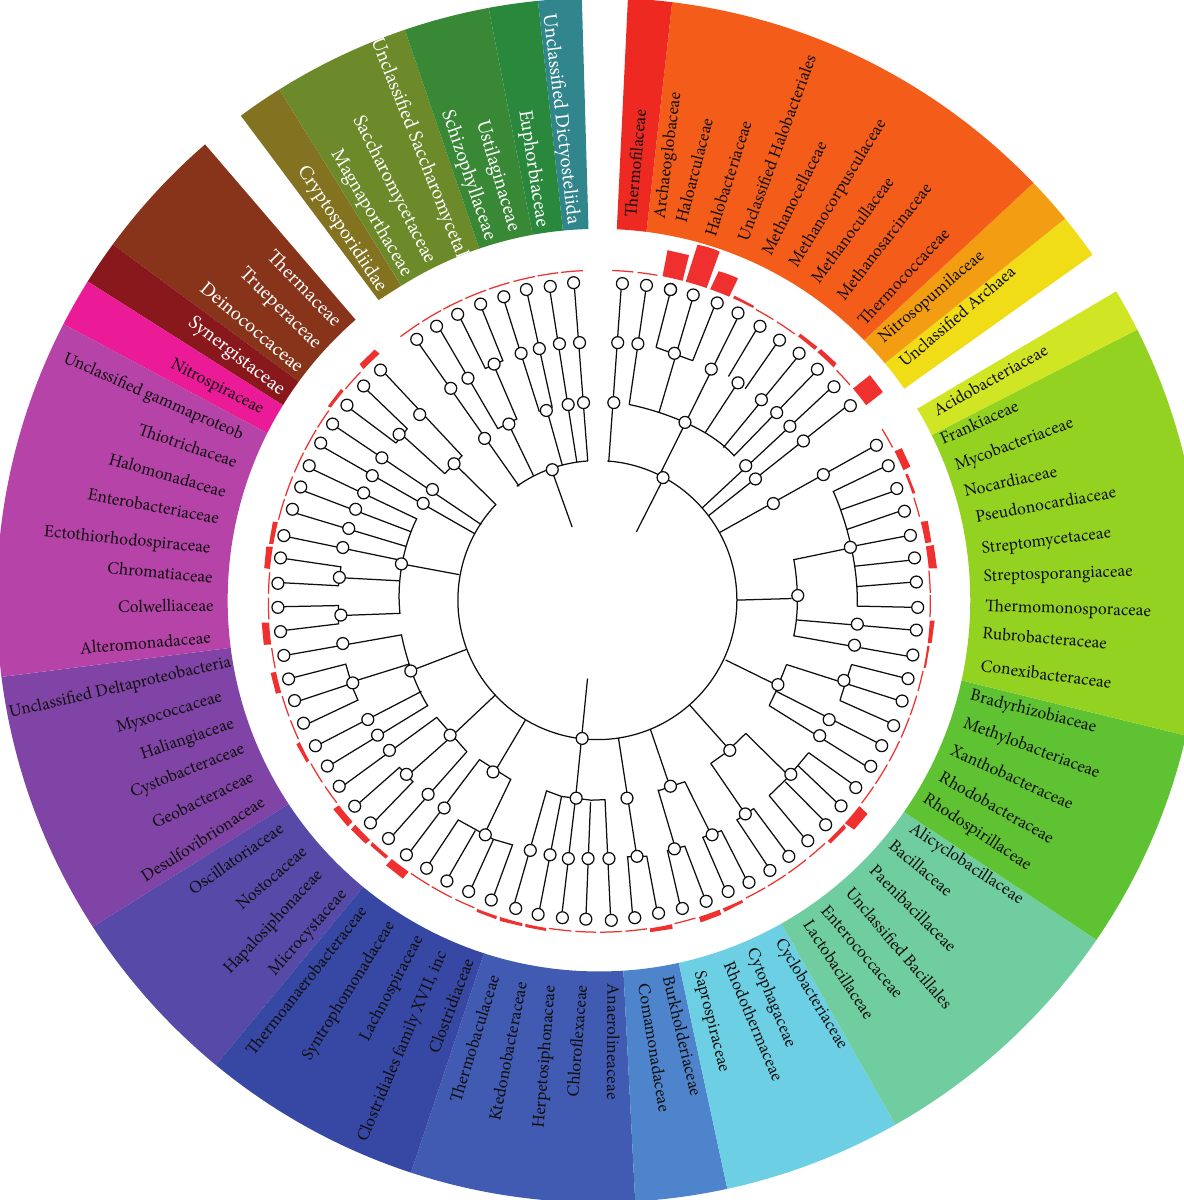
Figure 2: Radial phylogenetic tree comparison between H. hamelinensis and the bacterial and archaeal lineage within IMG/ER database. Genomes of Archaea, Bacteria, and Eukaryota are displayed clockwise on the circular plot. The bar charts in between the circular plot and phylogenetic dendrograms are percentage representations of positive hits of genes between H. hamelinensis and respective genomes.